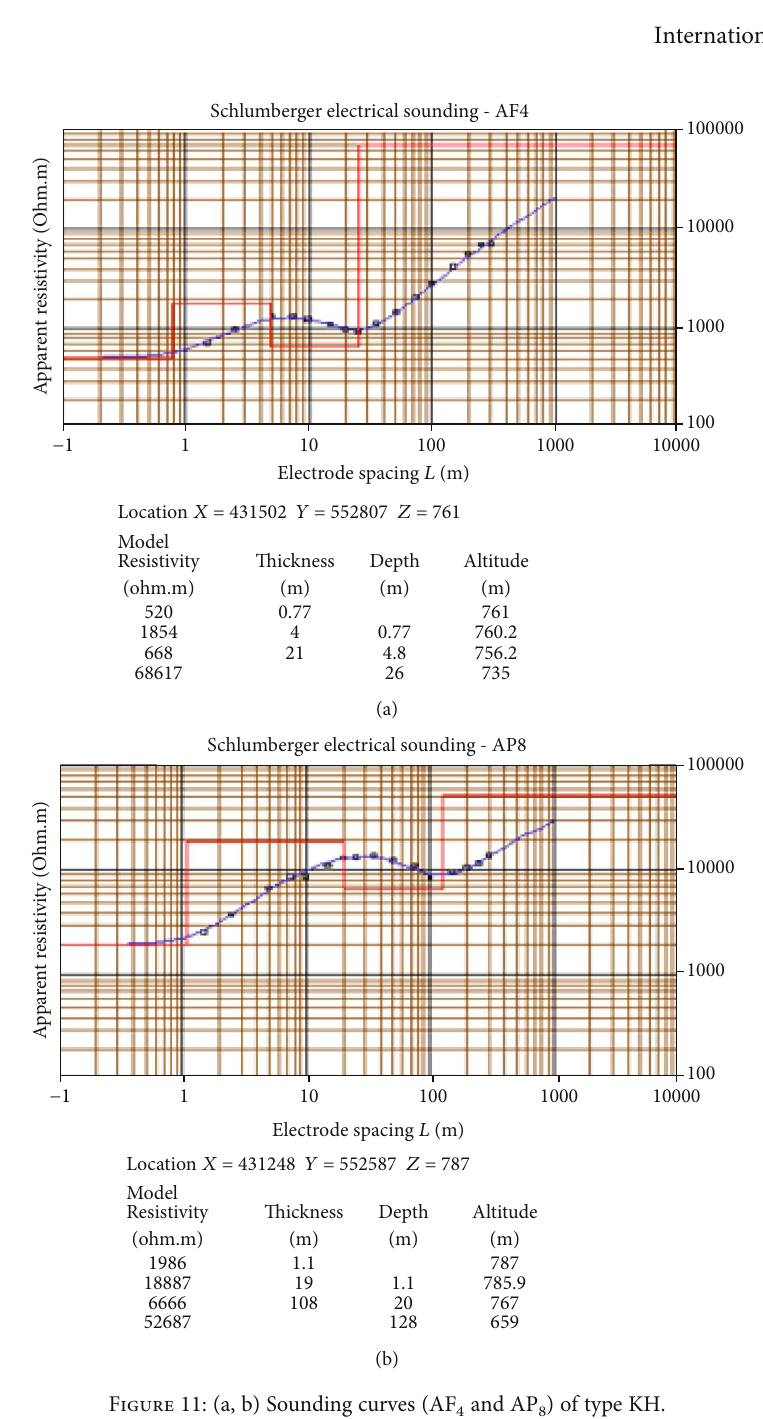
and AP ) of type 4 8